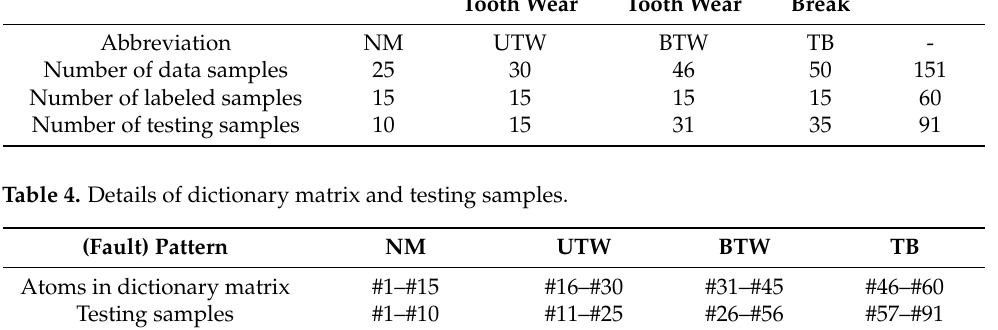
Table 3. Data sets description.